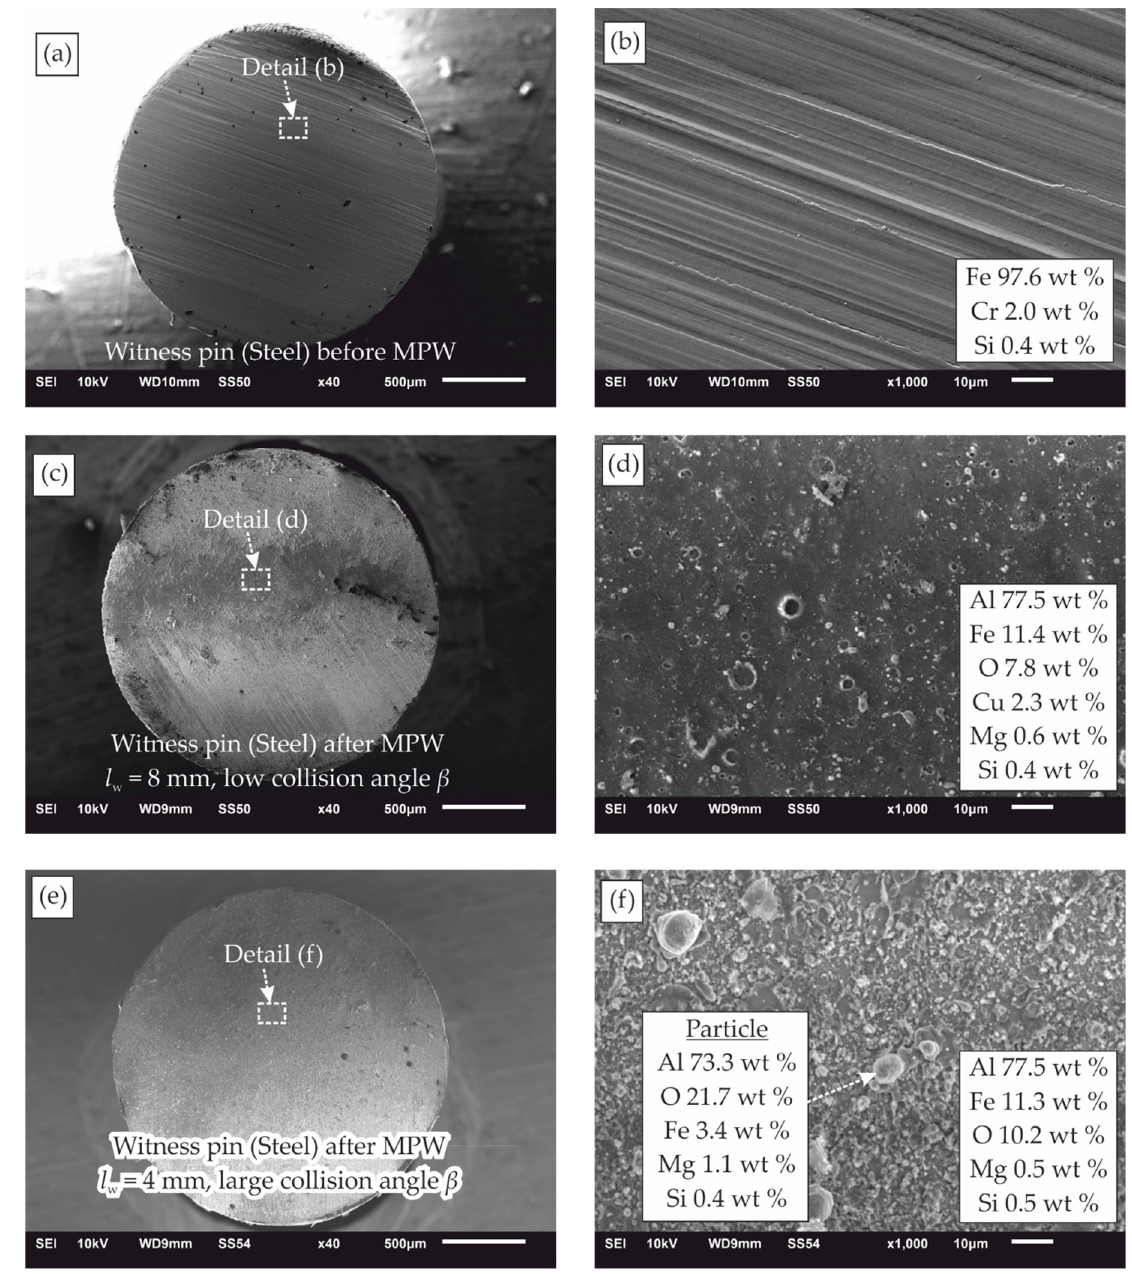
Figure 14. Surface topography and chemical composition of the steel witness pins ( a , b ) before MPW and after MPW with ( c , d ) low collision angle and ( e , f ) large collision angle.